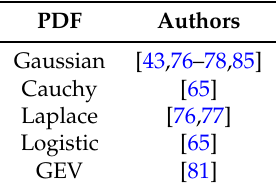
Table 5. Comparison PDF of EMG signals.